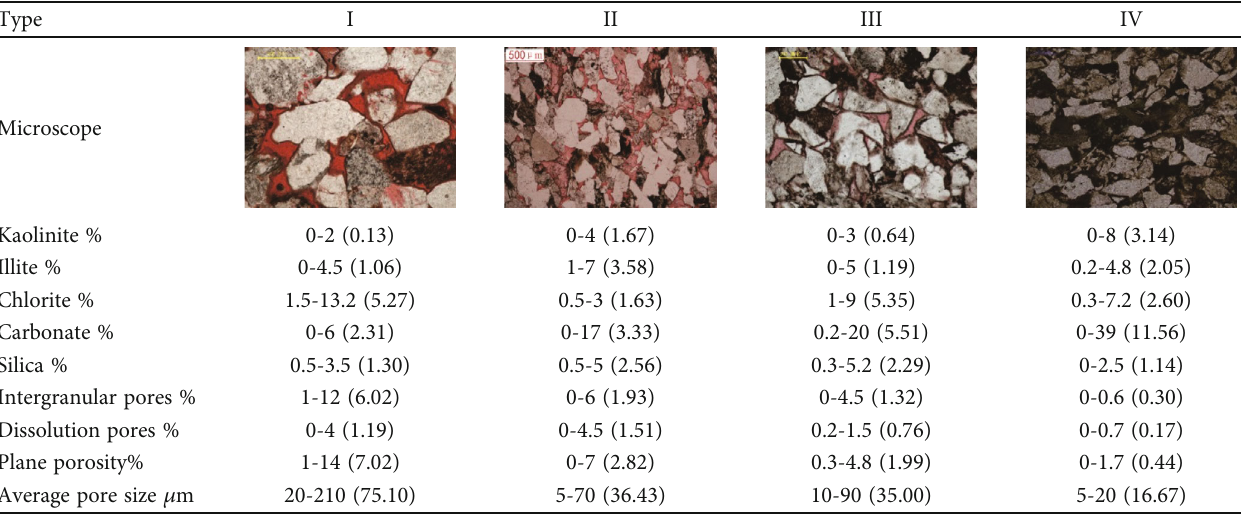
Table 6: Classi fi cation of diagenetic facies types and microscopic characteristic parameters in the study